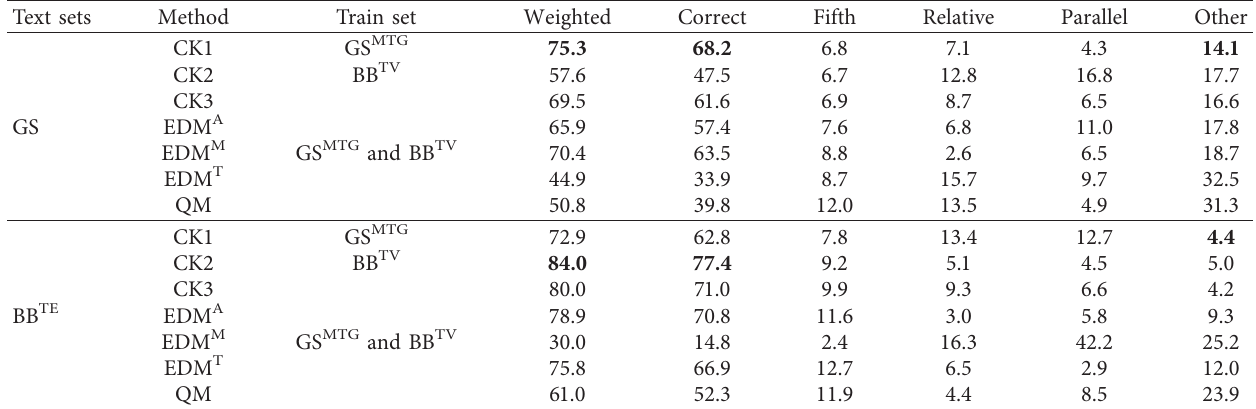
reference systems if trained on the correct genre: 75.3 vs.